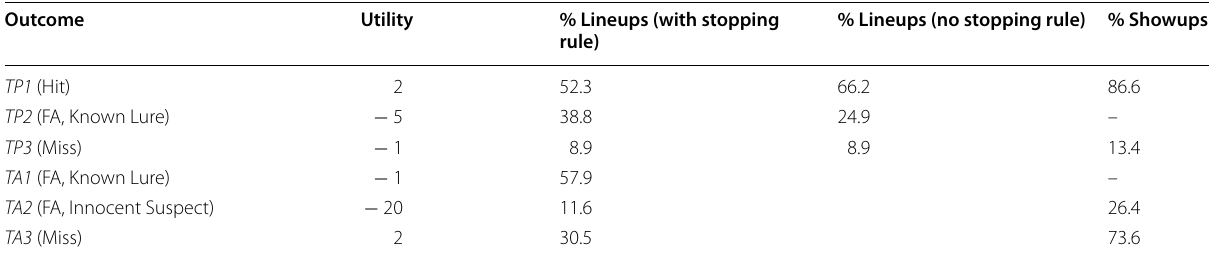
FA, false alarm. Please note that outcomes TP2 and TA1 are not possible in the case of showups